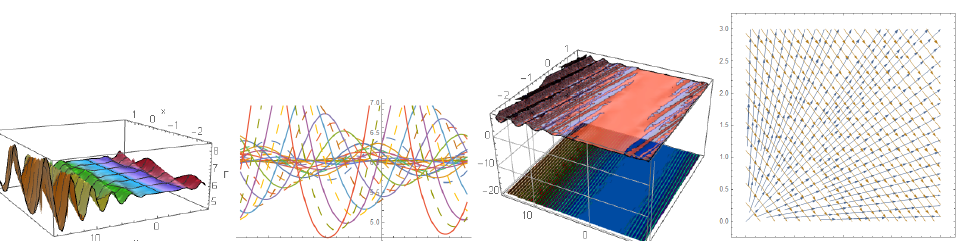
Figure 6. The graphs of Γ 2 ( x , y , t ) in Equation (16) via g 6 = 3, c = 1, ρ = − 1, η = 1, λ = 1, g 1 = 3, δ = − 2, g 4 = 3, z 1 = 1, and t = 5.